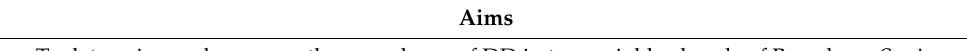
Table 5. Prevalence of DD in two socially different neighborhoods and relevance of community-based mental health